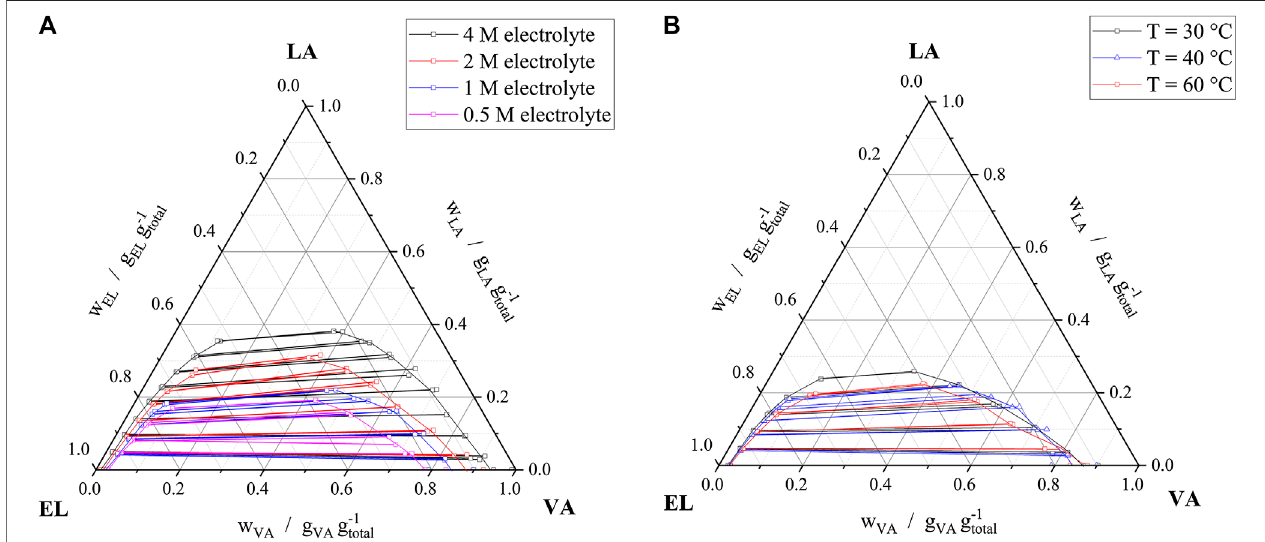
FIGURE 2 | Liquid – liquid equilibrium data of the system valeric acid (VA), levulinic acid (LA), and aqueous H 2 SO 4 (EL) at (A) different molar concentrations of the electrolyte (T (cid:2) 40 ° C) and (B) at T (cid:2) 30, 40, and 60 ° C for an EL concentration of 1 M.